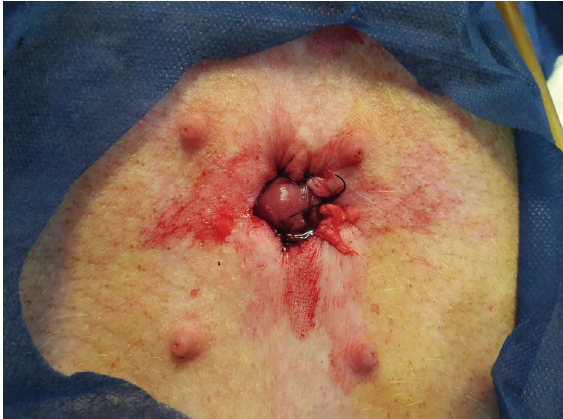
Figure 1 - Single-port Intragastric sleeve in pigs - Fixation of the stomach to the skin through four interrupted sutures with 0 nylon.